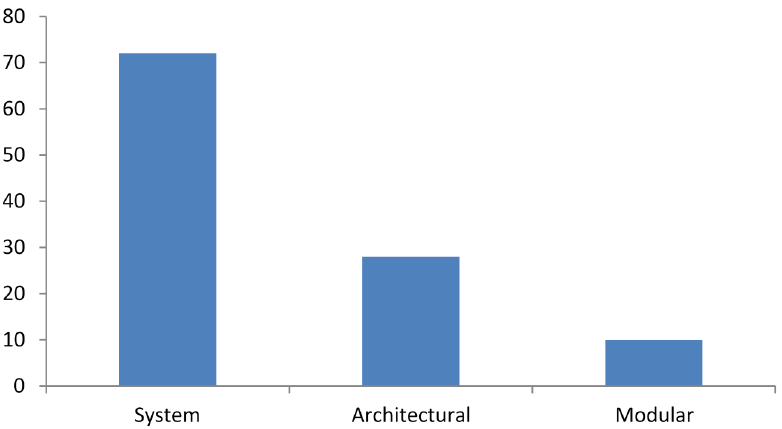
Figure 5. Innovation novelty categories that delivered a combination of quality-time-cost benefit.